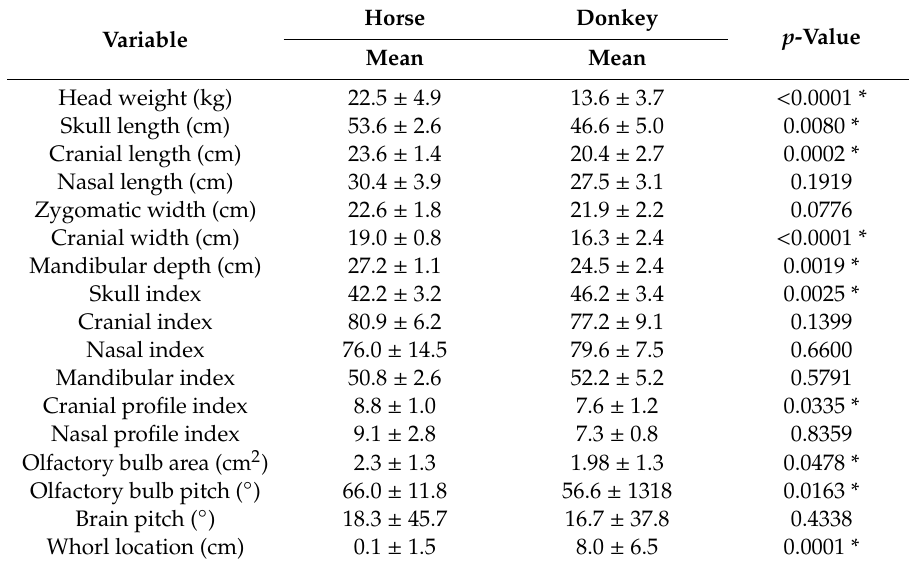
Table 1. Morphometric measurements (mean ± SD) of horse ( n = 12) and donkey ( n = 14) skulls. P values were calculated using a General Linear Model, with a value < 0.05 considered significantly di ff erent. Horse Donkey Variable